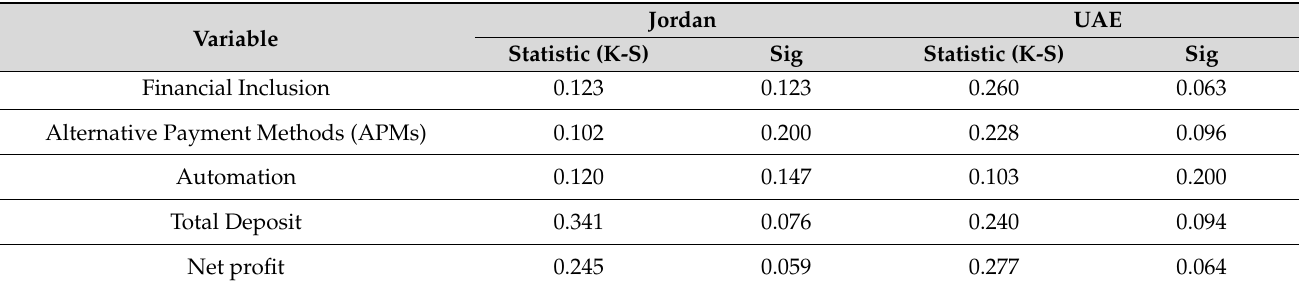
Table 7. Results of the Normal Distribution Test for the Study Data.